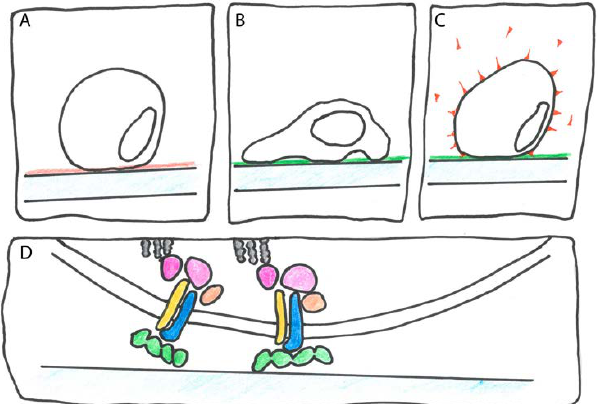
Figure 2. Cell adhesion assay. ( A ) On an uncoated or control-coated (red) plastic substrate, cell adhesion is inefficient; ( B ) cells adhere rapidly when plastic is coated with an adhesion protein such as Tgfbi or Pn (green); ( C ) to identify the receptor for the adhesion protein, integrin isotype specific antibodies (red) are co-incubated; ( D ) mammalian FAS1 proteins are thought to bind to different types of dimeric integrins (blue and yellow) that mediate mechanical contact between the cytoskeleton (grey) and the ECM as well as transduce intracellular signals using numerous associated proteins (pink and nude).